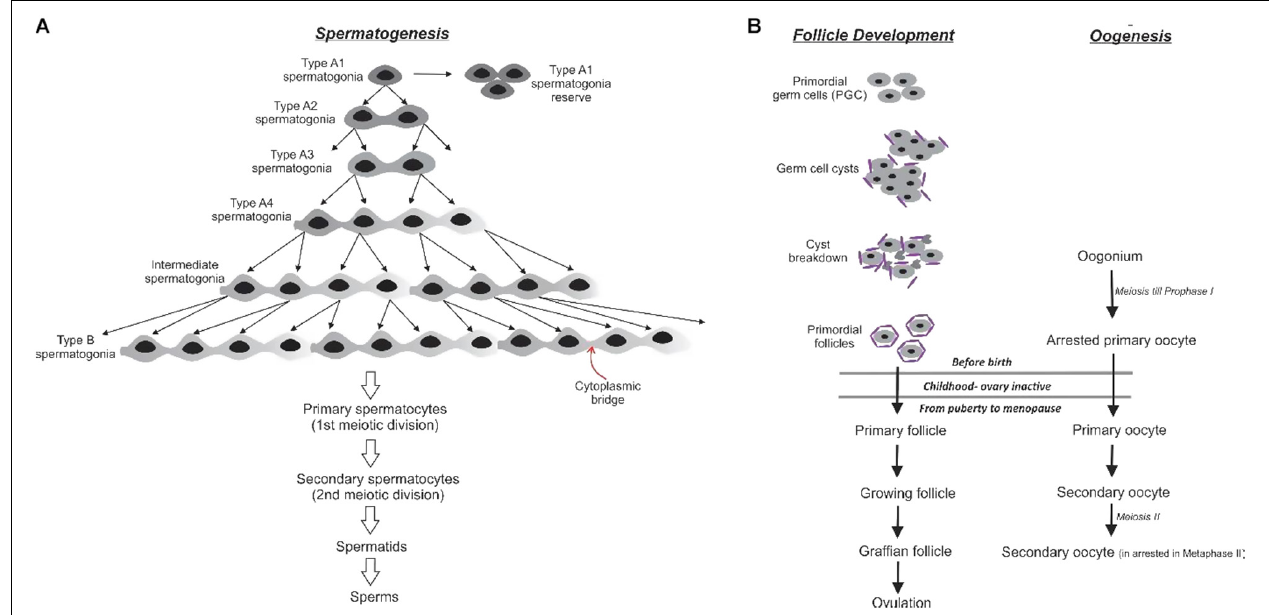
FIGURE 5 | Gametogenesis in the human reproductive system: (A) In male spermatogenesis there is the presence of cytoplasmic bridges that connect the pre-meiotic sperm precursor cells allows the sharing of resources via cytoplasmic gradients between diploid cells from the same progenitor germ cells (B) in the female follicle development, germ cell cysts are connected oogonia that assist in the development of a primordial follicle.